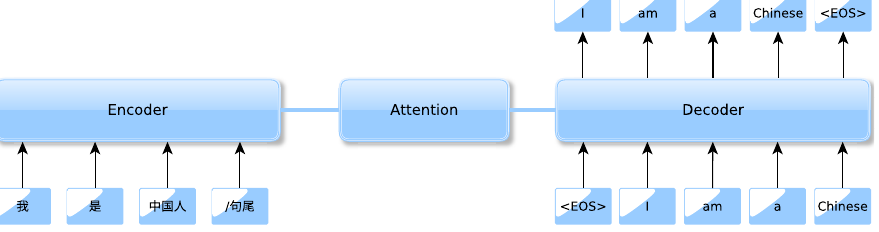
Figure 1. A standard NMT model based on the encode-attend-decode modeling